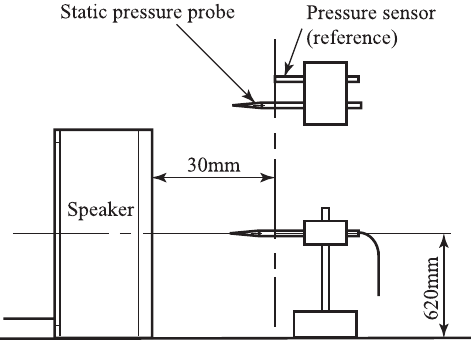
Fig. 3 Experiment of frequency